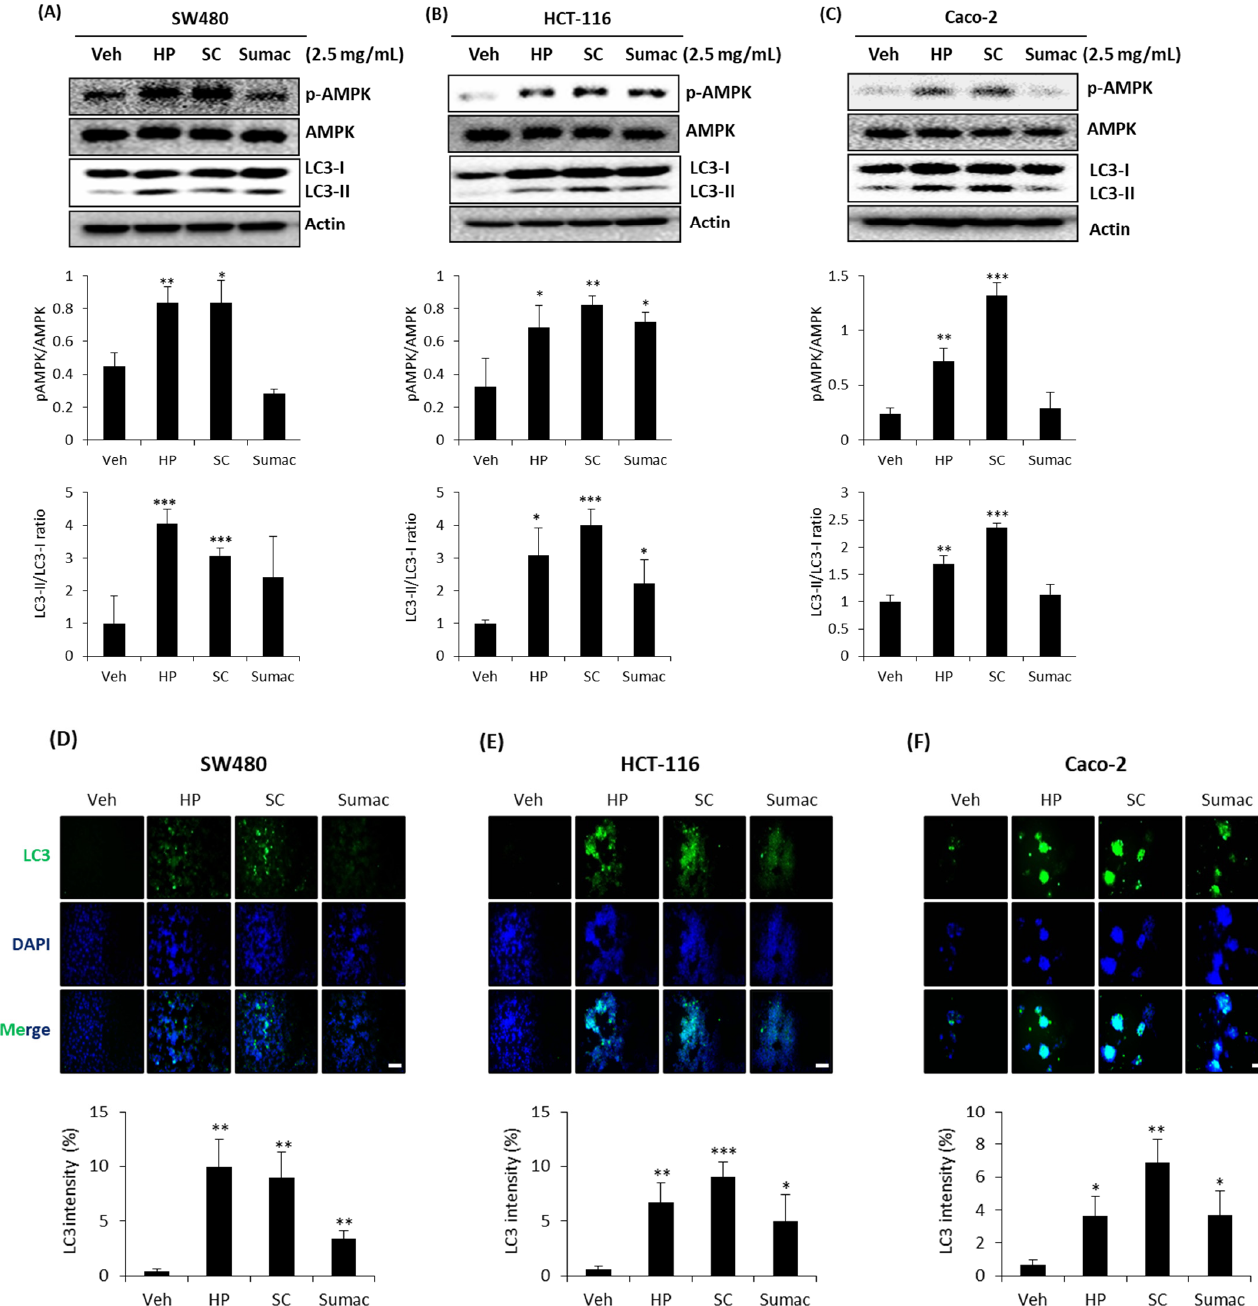
Figure 5. High phenolic sorghum bran extracts activate AMPK and autophagy in human colon cancer cells. ( A – C ) Three human colon cancer cells, SW480 ( A ), HCT-116 ( B ), and Caco-2 ( C ) cells, were treated with 2.5 mg/mL of sorghum bran extracts (HP, SC and Sumac) for 6 h and Western blotting was performed using antibodies against indicated proteins. ( D – F ) Immunofluorescence was performed to determine LC3 intensity in SW480 ( D ), HCT-116 ( E ) and Caco-2 ( F ) cells treated with 2.5 mg/mL of HP, SC and Sumac for 6 h. Scale bar represents 200 micrometers. Values are the mean ± SD (n = 3). Significant differences between the vehicle- and sorghum bran extract-treated groups are indicated as * p < 0.05, ** p < 0.01, *** p < 0.001.